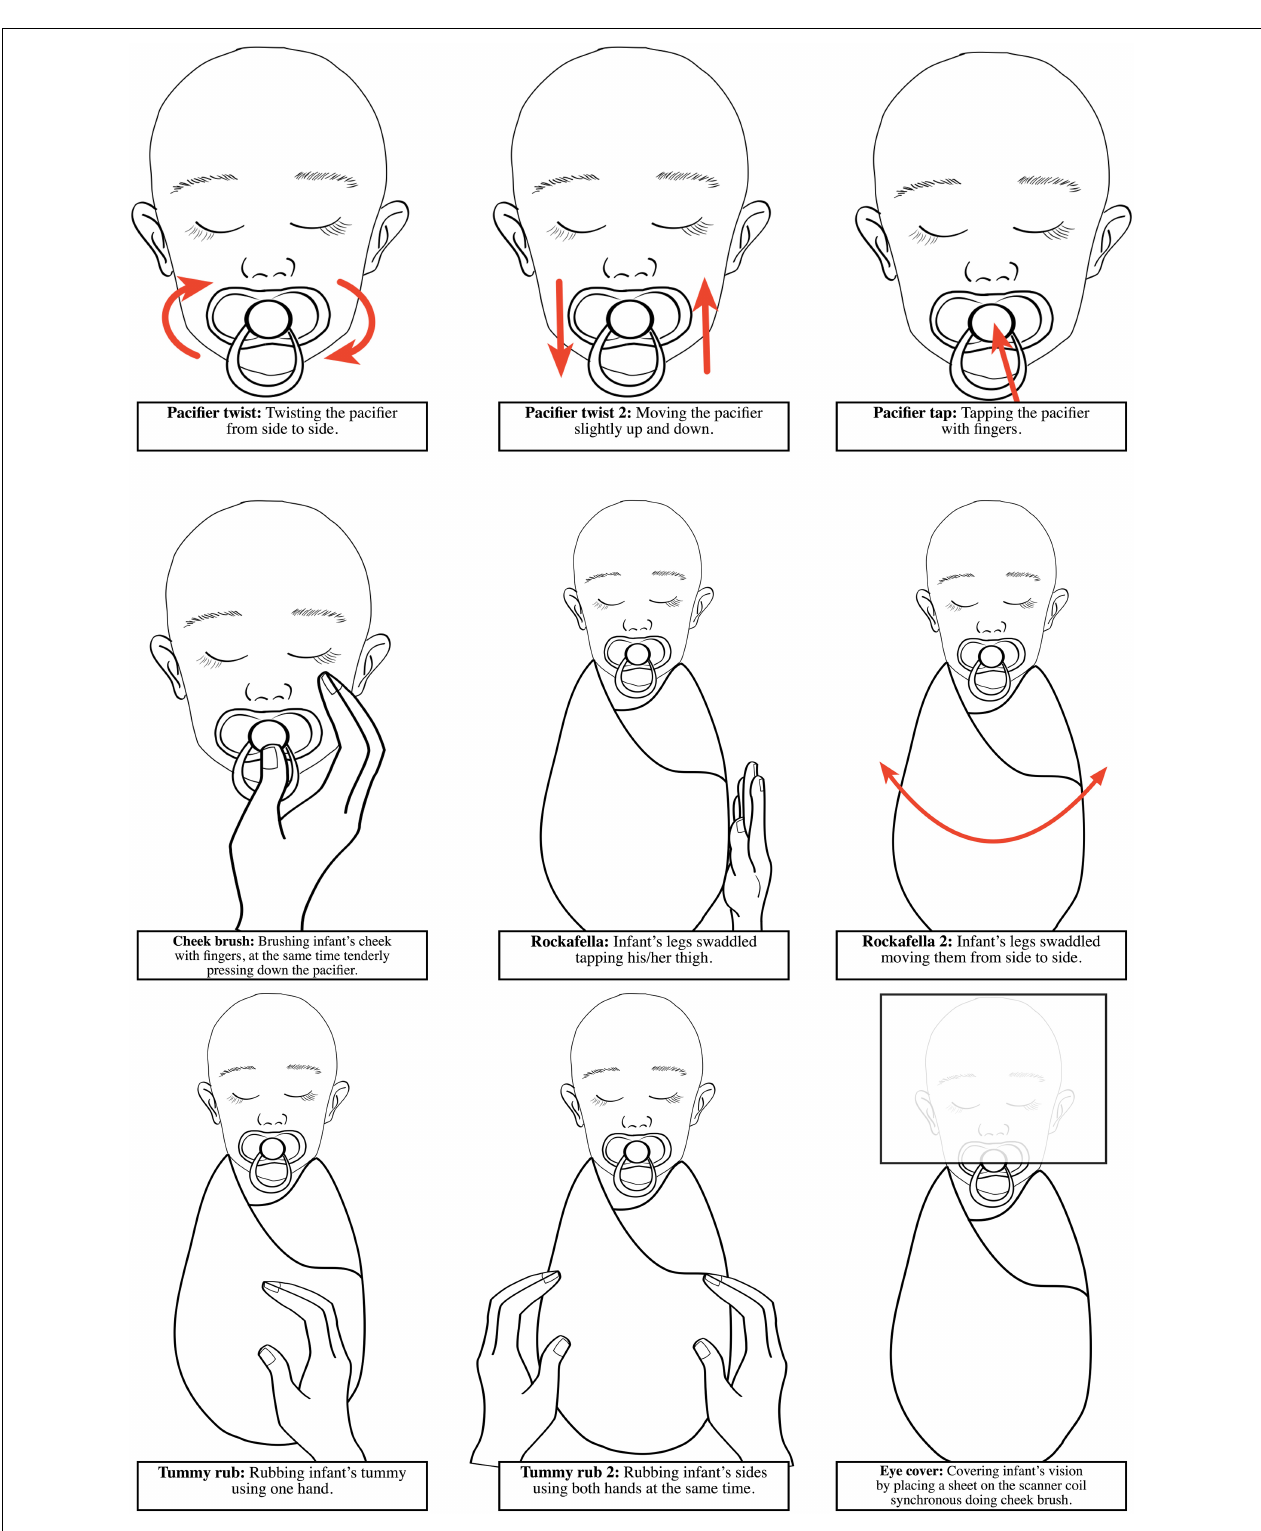
FIGURE 3 | Schematic illustrations of the procedures used to calm the infants if they woke up during the scan in the FinnBrain Study. All procedures can be made by carefully reaching inside the scanner bore.